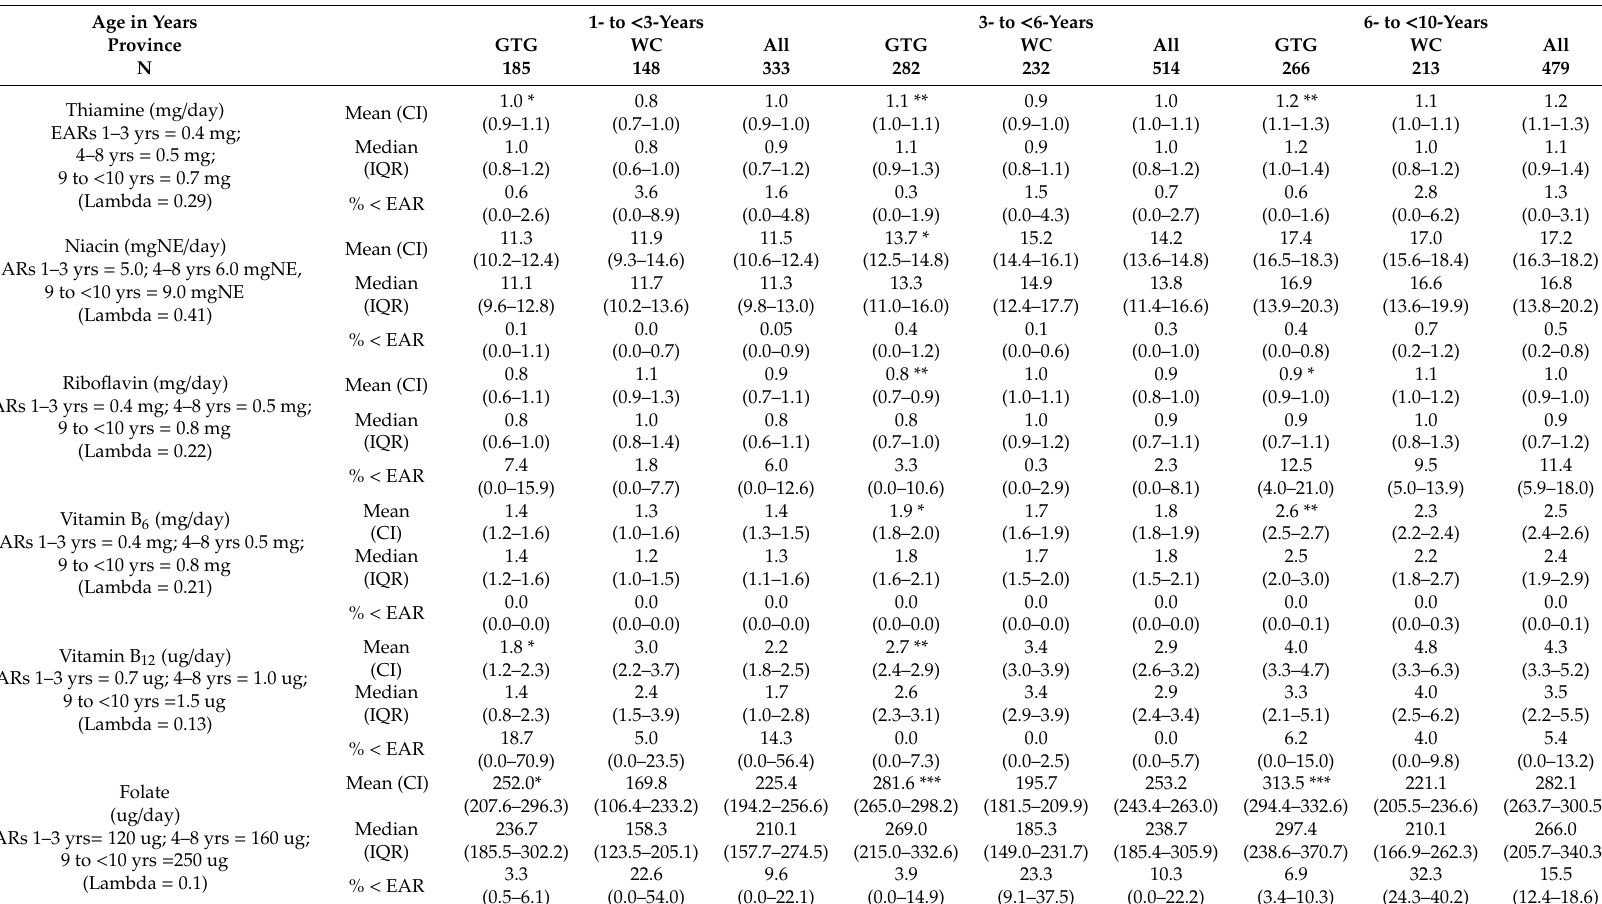
Table 4. Mean (CI), median (IQR) and percentage intake below the EAR for B vitamins (adjusted) of children aged 1 to < 10 years by province and